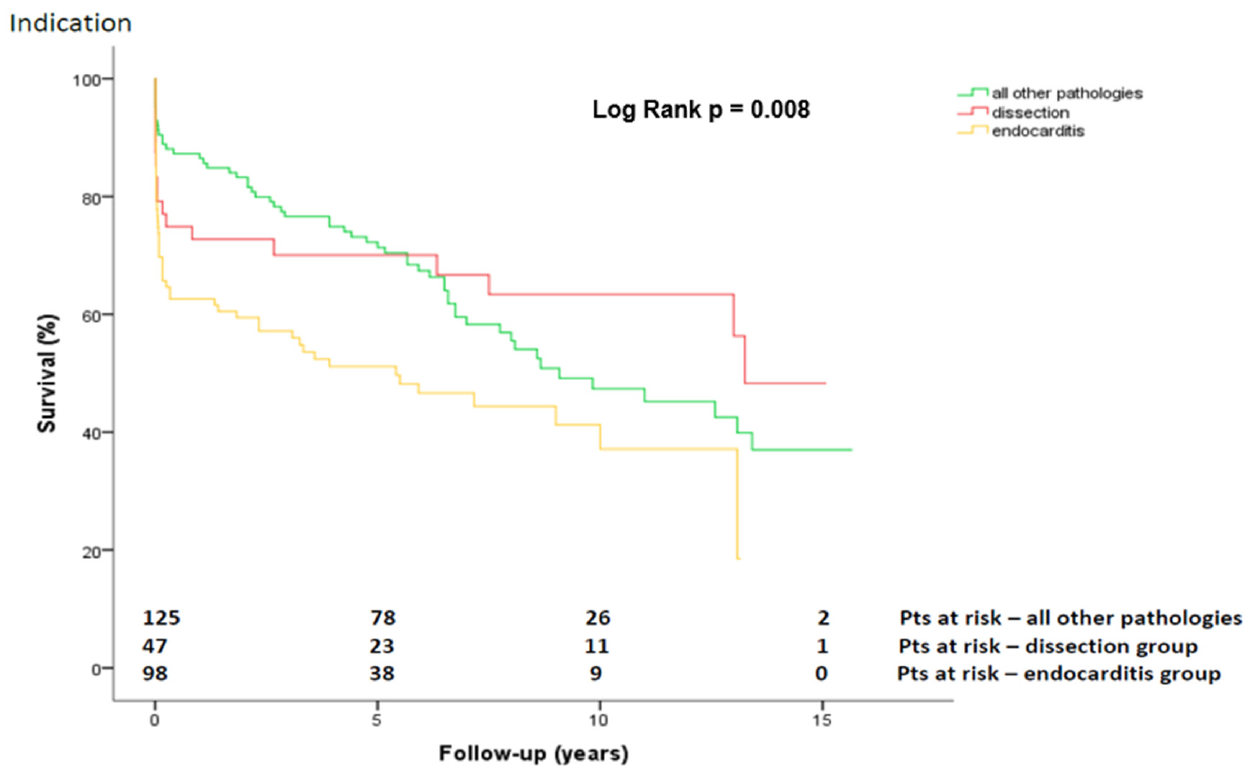
Figure 3. Kaplan–Meier curve showing survival after Bentall–De Bono operation in dissection vs. endocarditis vs. other pathologies group. Pts: patients.